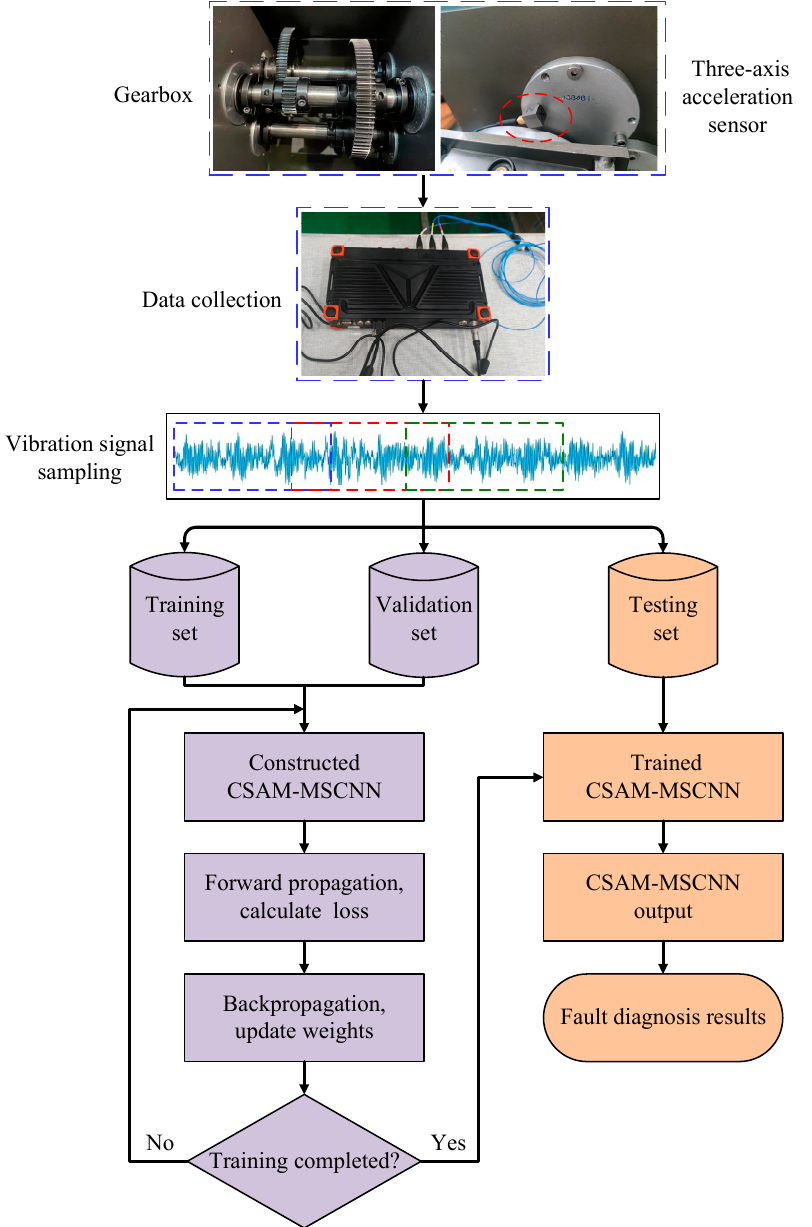
Figure 7. Fault diagnosis process based on the